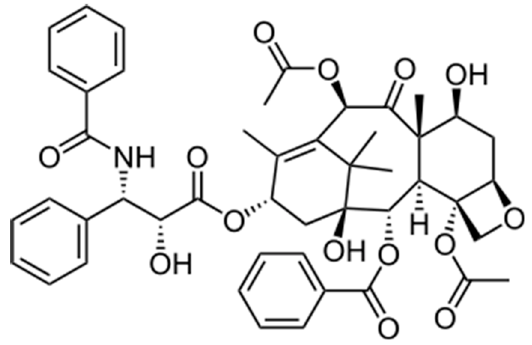
Figure 1. Structure of Taxol ®.